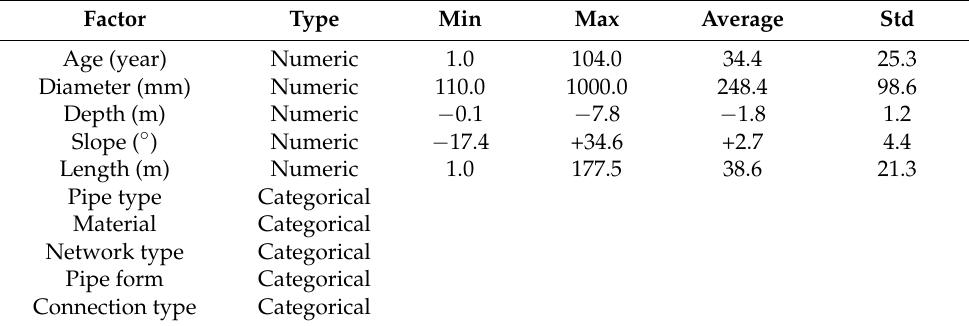
Table 1. Summary of physical factors in this study.